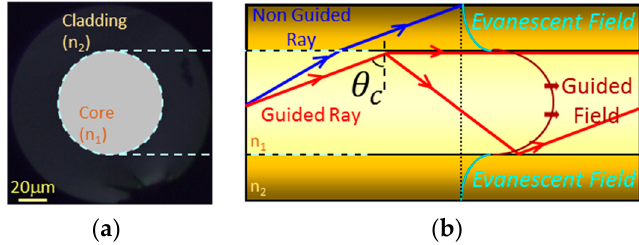
Figure 1. ( a ) On the left hand side, the transversal section of the optical fibre showing core (highlighted) and cladding; ( b ) on the right hand side, the longitudinal section showing the signals involved in light propagation explained by ray theory (arrows) and electromagnetic field theories.